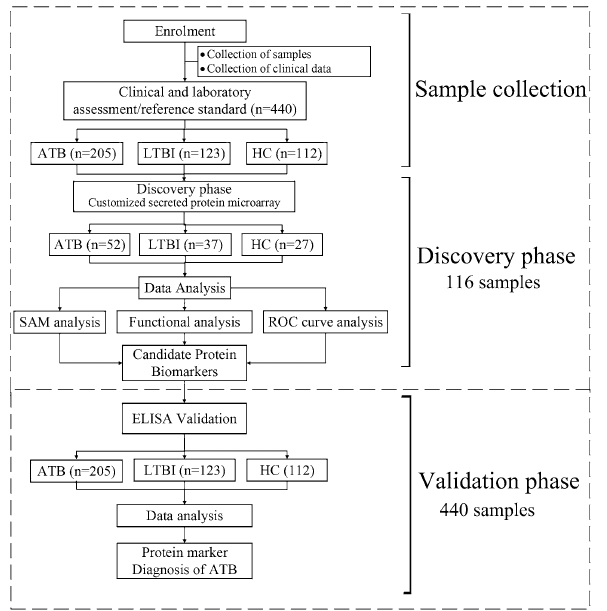
Figure 1. Identification of serum biomarkers that can discriminate between ATB and LTBI/healthy groups. Overall study